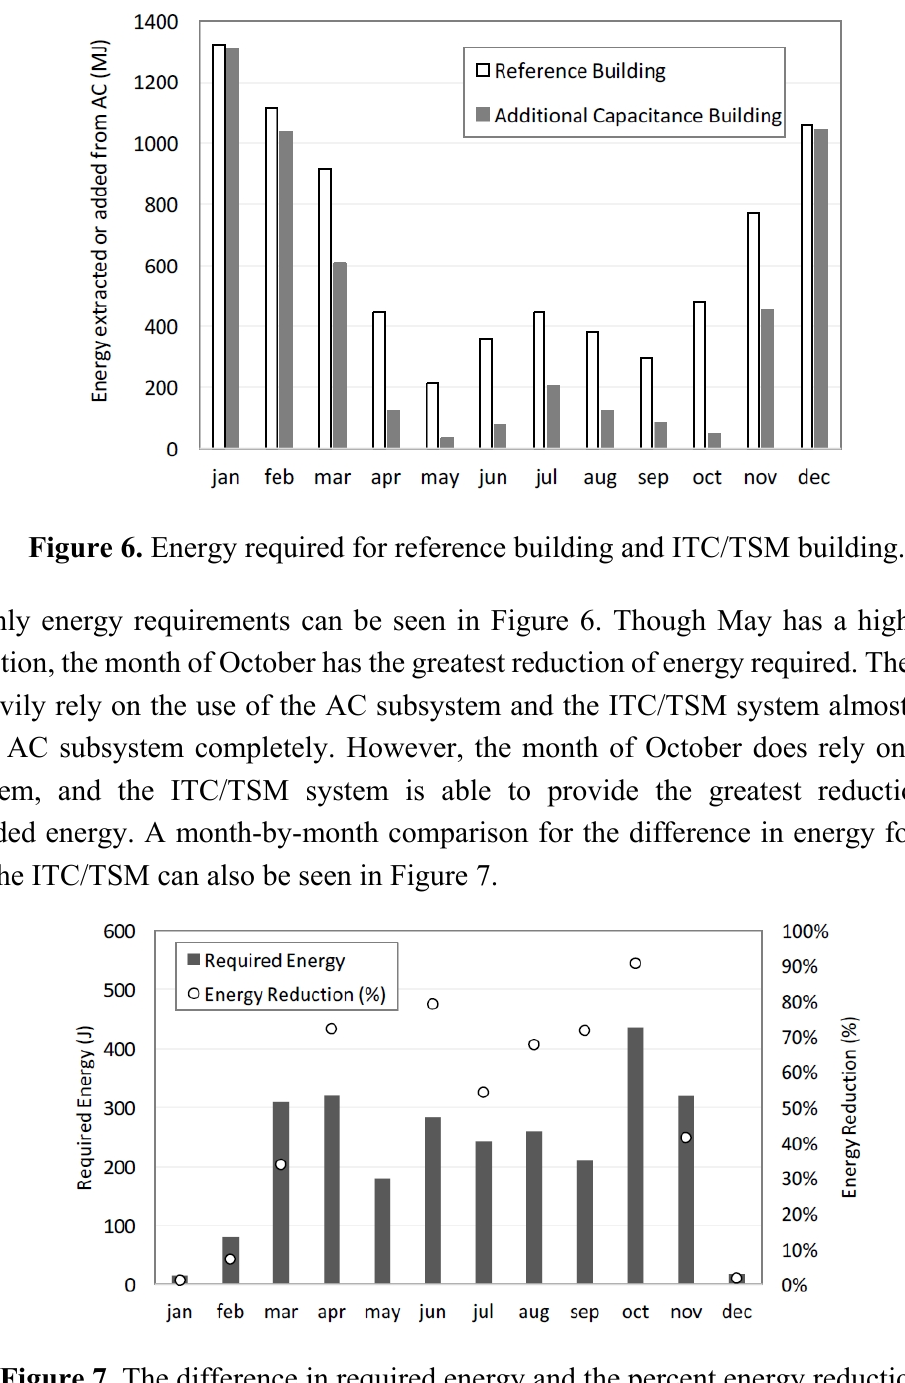
Figure 7. The difference in required energy and the percent energy